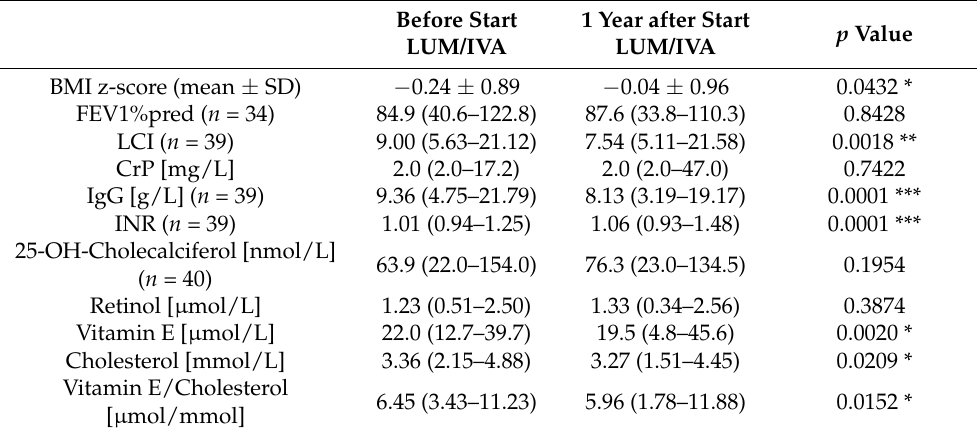
Table 2. Course of clinical parameters and fat-soluble vitamins after one year of therapy with lumacaftor/ivacaftor (LUM/IVA) in a cohort of 41 CF patients. Before